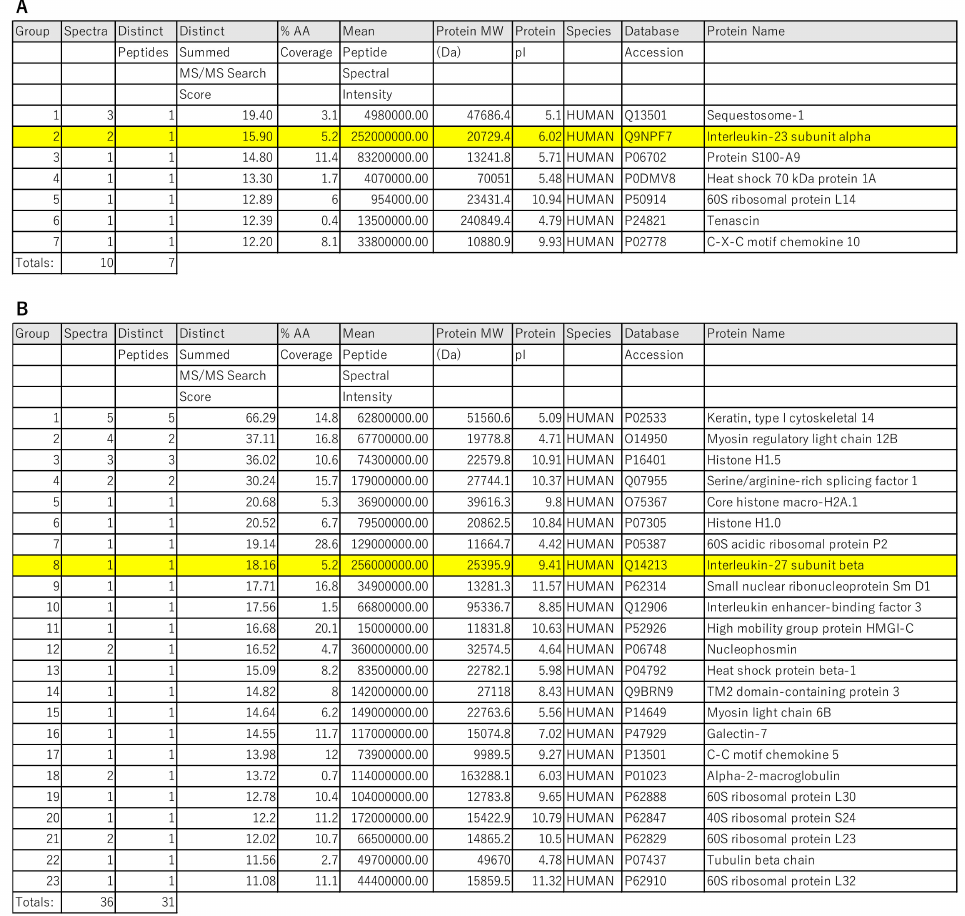
Figure 5. Proteins detected by immunoprecipitation with tildrakizumab or anti-human EBI3 antibody and LC-Ms/Ms. Culture supernatant of NHEKs stimulated with the triplet mixture of cytokines (50 ng/mL, TNF- α , IL-17A and IFN- γ ) for 48 h were immunoprecipitated with ( A ) humanized anti-human IL-23Ap19 antibody or ( B ) rabbit anti-human EBI3 antibody and magnetic beads. The detected proteins were analyzed by liquid chromatography–electrospray tandem mass spectrometry (LC-Ms/Ms). The non-specific proteins detected in common with the control were